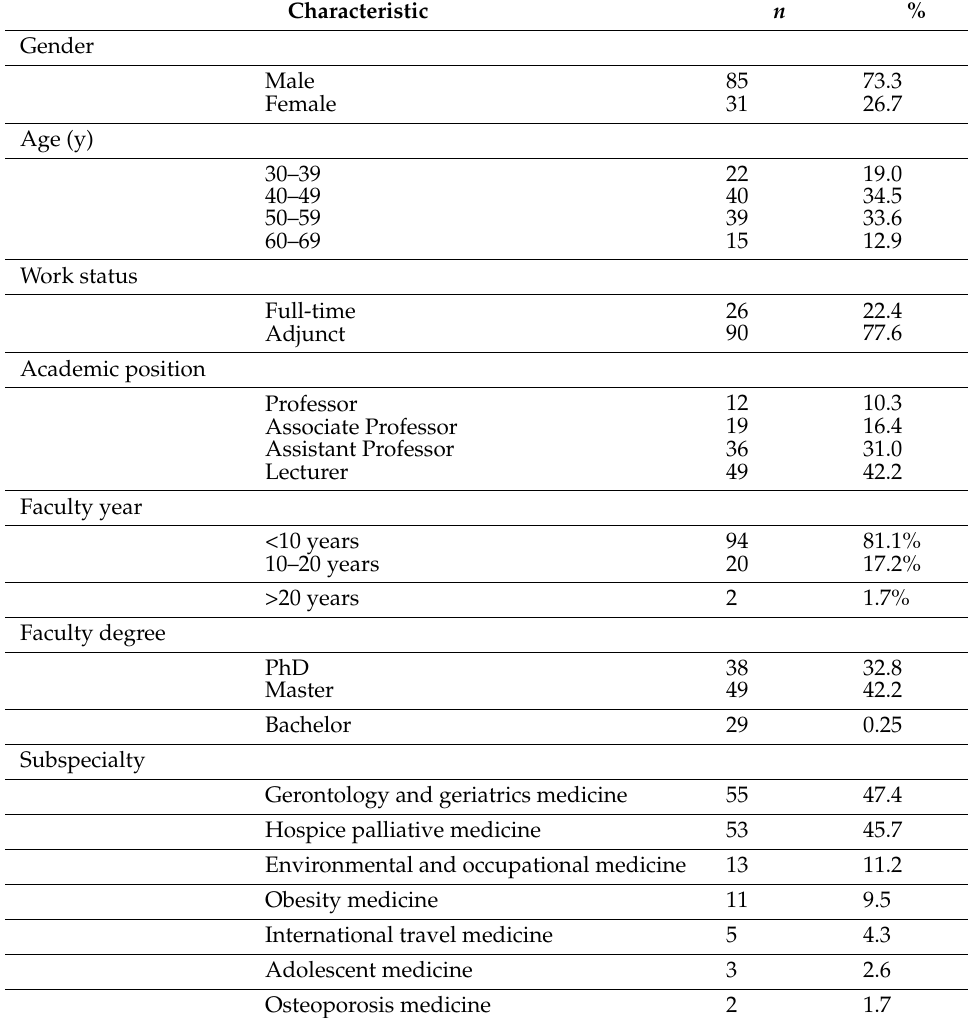
Table 3. Characteristics of family medicine faculty in medical schools in Taiwan ( n = 116). Characteristic n